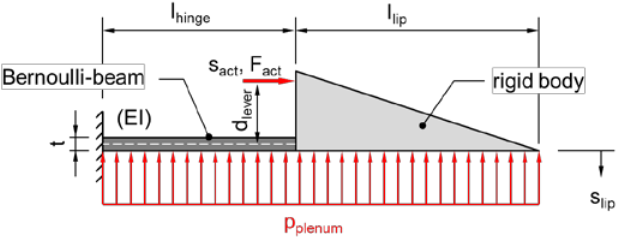
Figure 6. Simplified model of the actuated lip.